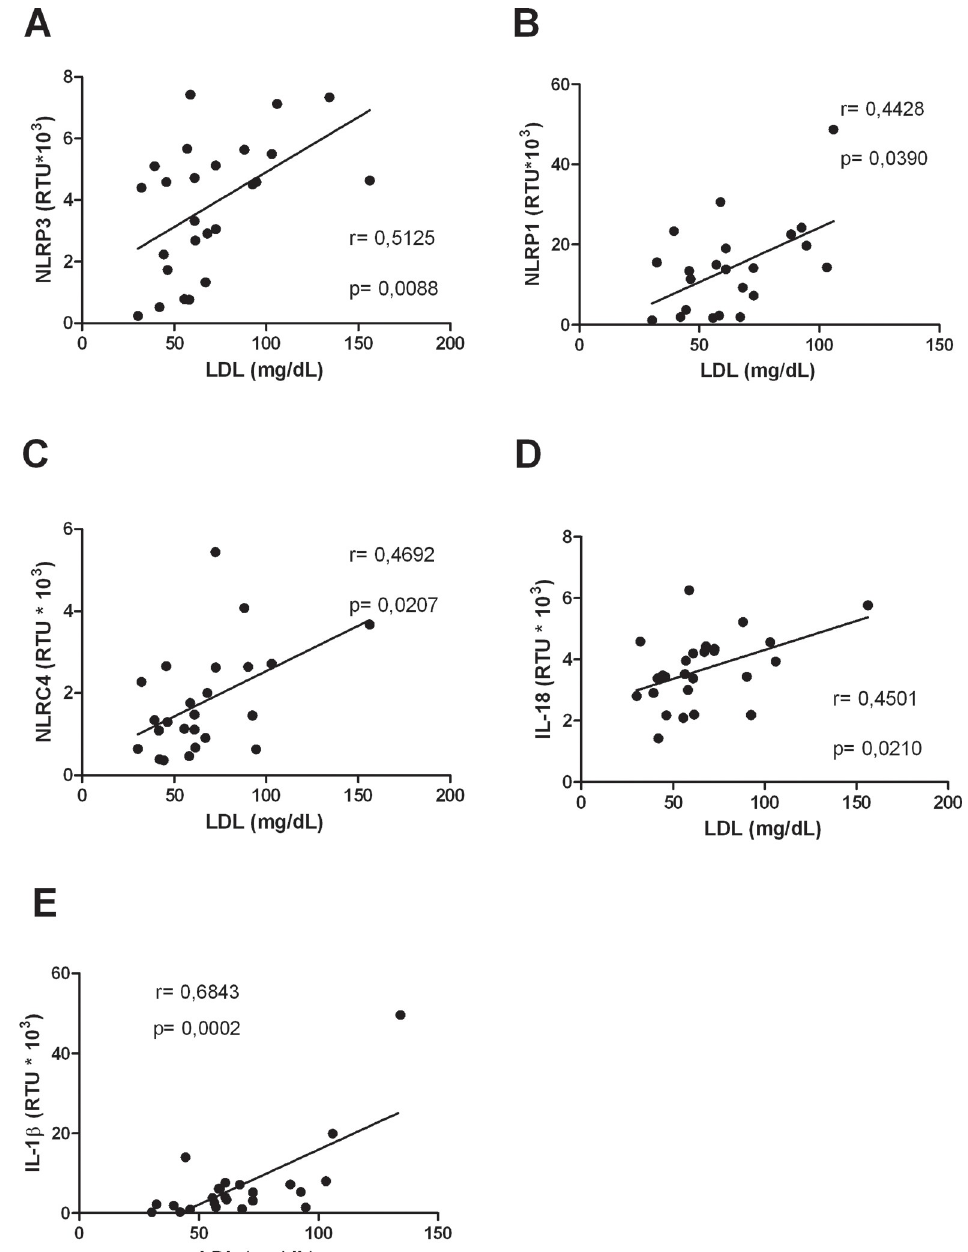
Fig 7. LDL levels are correlated with inflammasome-related genes. Correlation between LDL levels and (A) NLRP3, (B) NLRP1, (C) NLRC4, (D) IL-18 and (E) IL-1 β . Correlations between variables were assessed using the Spearman test. The r -value and p -value are indicated in each figure. A p -value of less than 0.05 was considered a significant